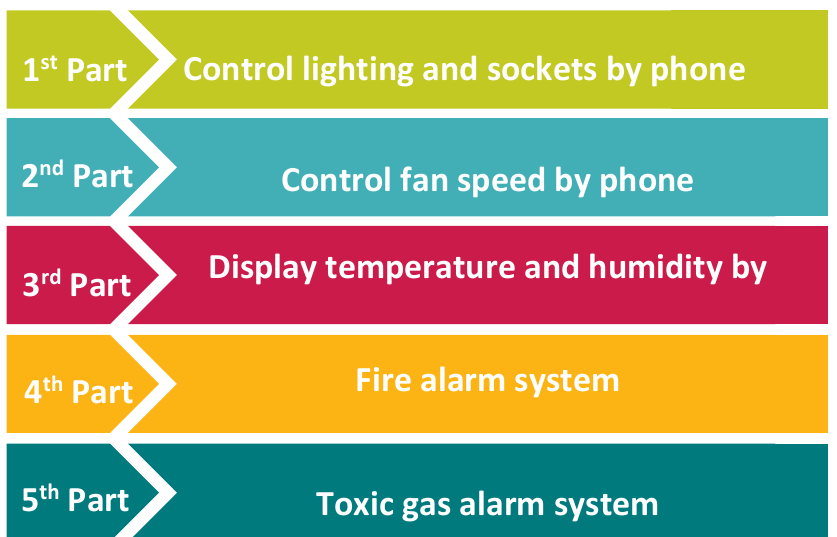
Figure 2. The work of RemoteXY in creating the graphical user interface.